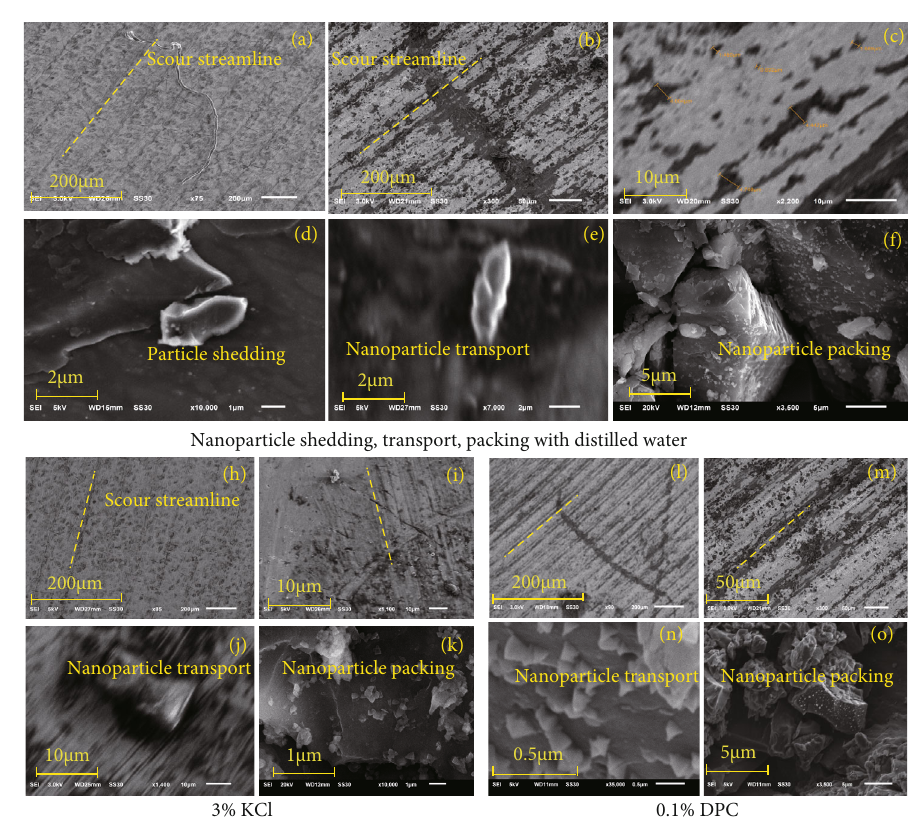
Figure 11: Micromorphology of coal sample after KCl scouring pollution.